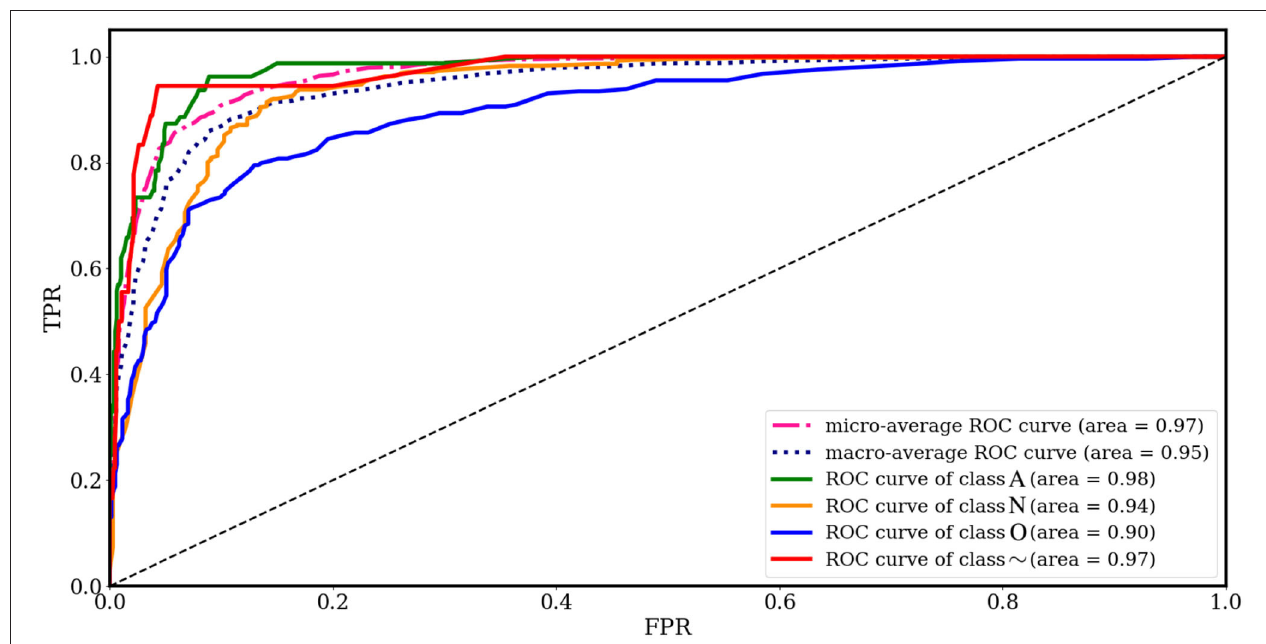
FIGURE 8 | ROC curves for different classes obtained from feature importance by SHAP and RF classification and 10-fold cross-validation.